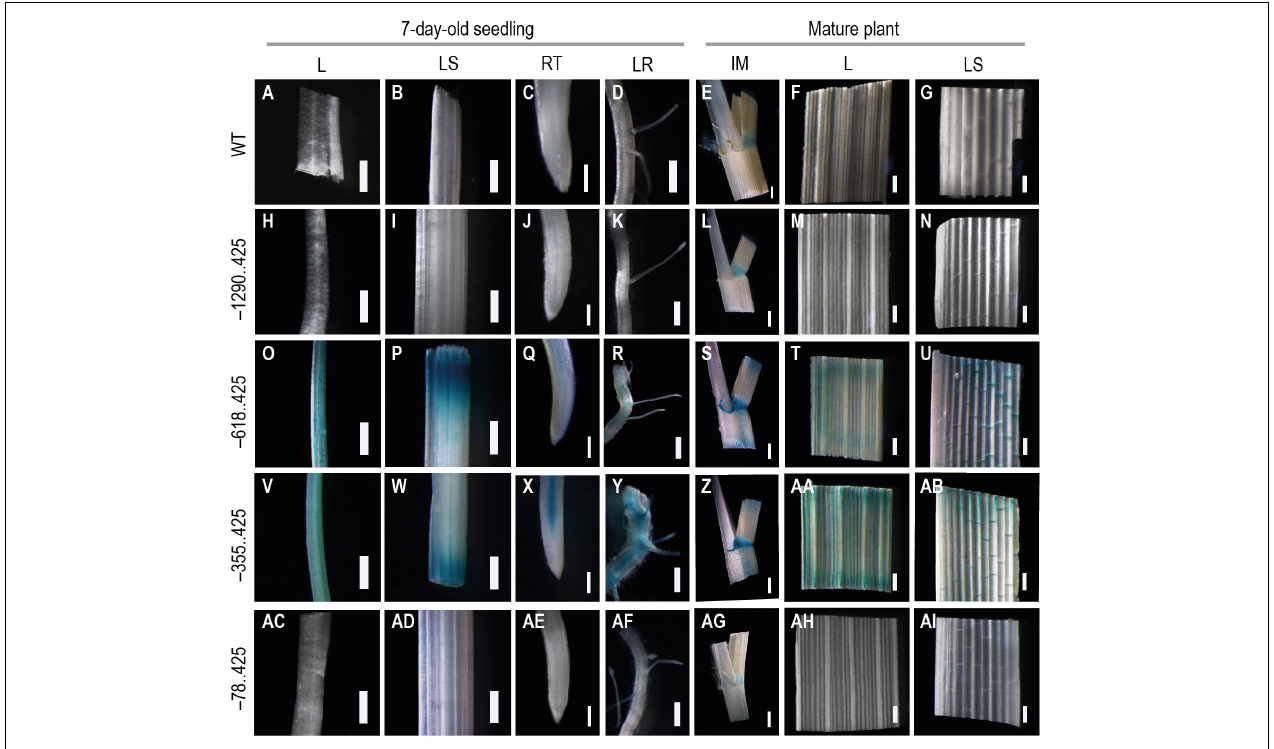
FIGURE 7 | Analysis GUS expression in vegetative tissues from young and mature WT and transgenic plants. The panel shows whole mounts of GUS-stained leaf (L), leaf-sheath (LS), root tip (RT), and lateral root (LR) from 7-day-old seedling and intercalary meristem (IM), leaf (L), and leaf-sheath (LS) from mature plants, (A–G) WT, (H–N) − 1290..425, (O–U) − 618..425, (V–AB) − 355..425, and (AC–AI) − 78..425 transgenic rice plants. Samples were photographed using a Leica Mz12.5 Stereozoom microscope. In 7-day-old-seedling samples, the scale bar represents 0.5 mm in L, LS, and LR samples and 0.2 mm in RT, in samples from mature plant 2 mm in IM, and 0.5 mm in L and